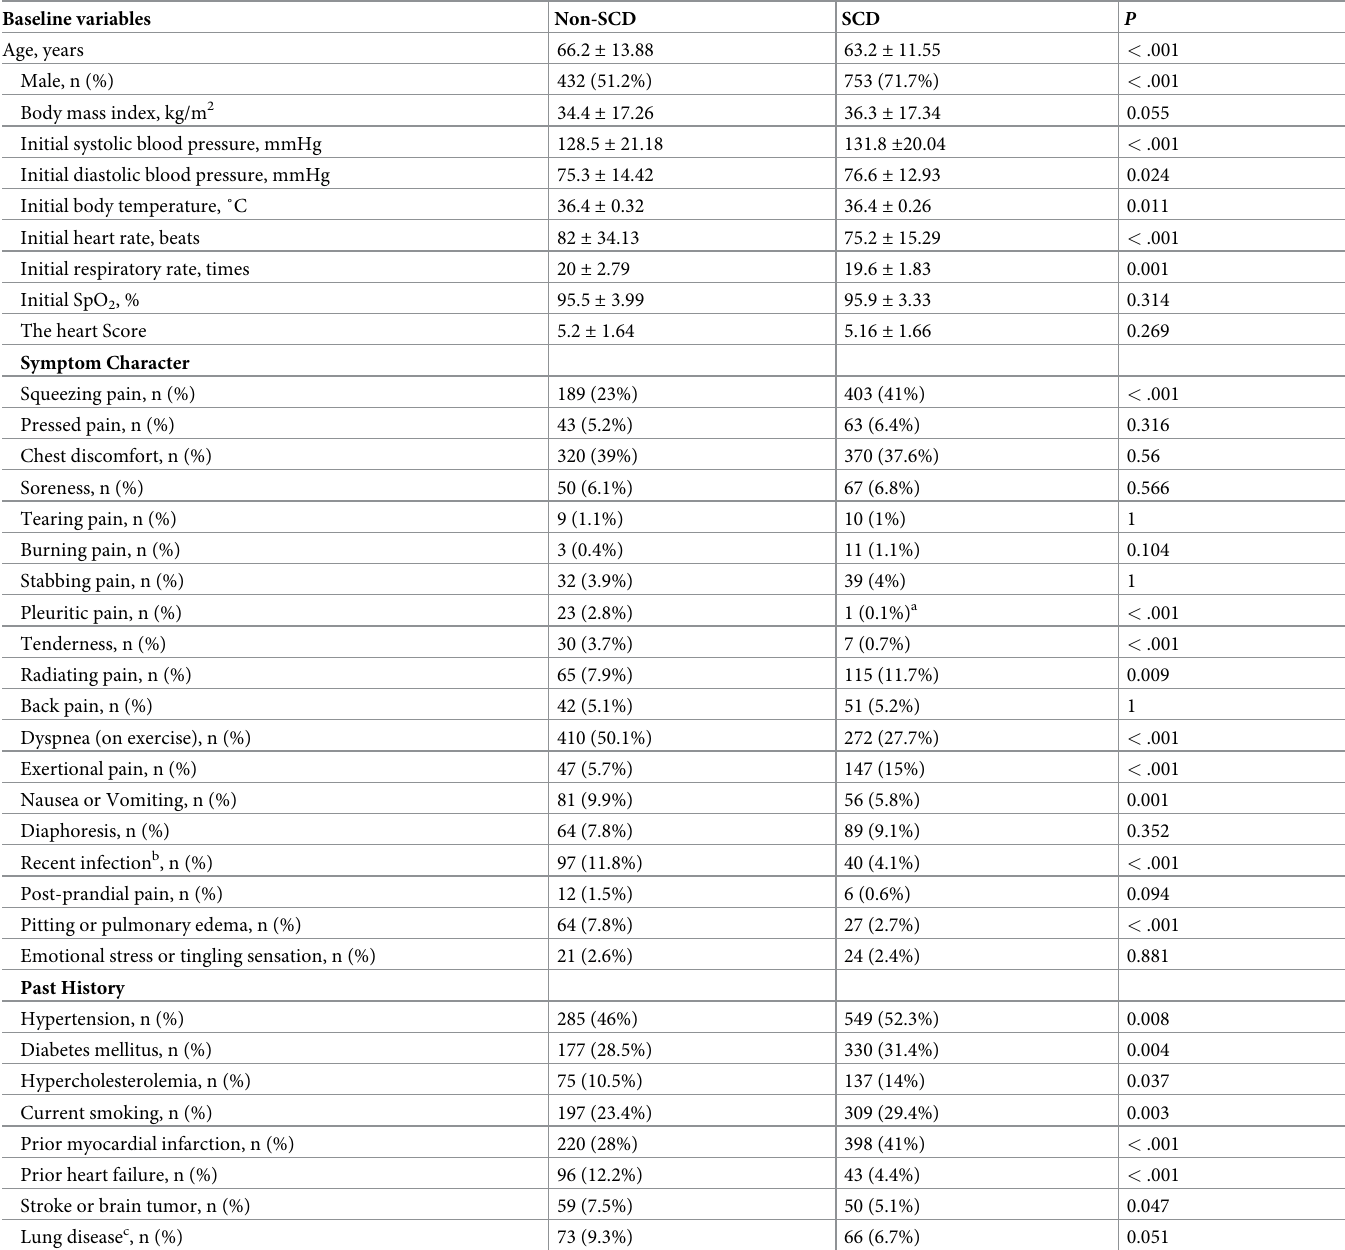
Table 1. Relation between coronary artery disorder and variables in demographic data, history, and physical